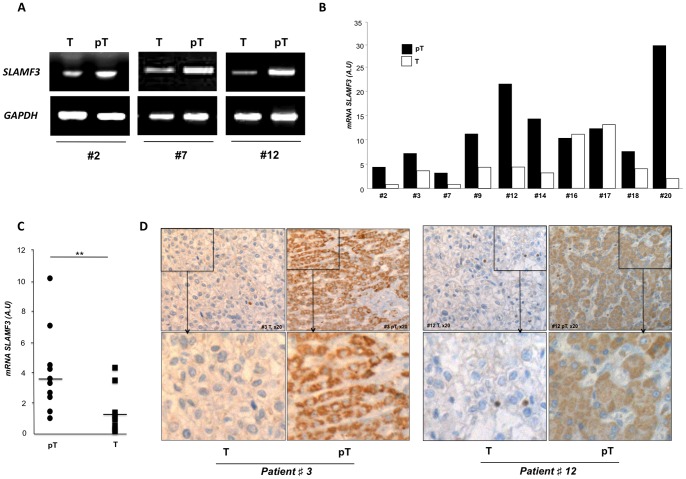
SLAMF3 expression is repressed in tumour cells from ten resected HCC patients.(A) SLAMF3 mRNA expression was analysed in hepatocytes from resected HCC patients. Specific amplification of SLAMF3 mRNAs using PCR (representative patients #2, #7 and #12) and quantitative PCR in tumour tissues (T) and peritumoral tissues (pT) presented separately (B) and as median (**p<0.05) (C); (D) Immunohistochemical staining of SLAMF3 in T and pT areas from representative patients #3 and #12 (×20).